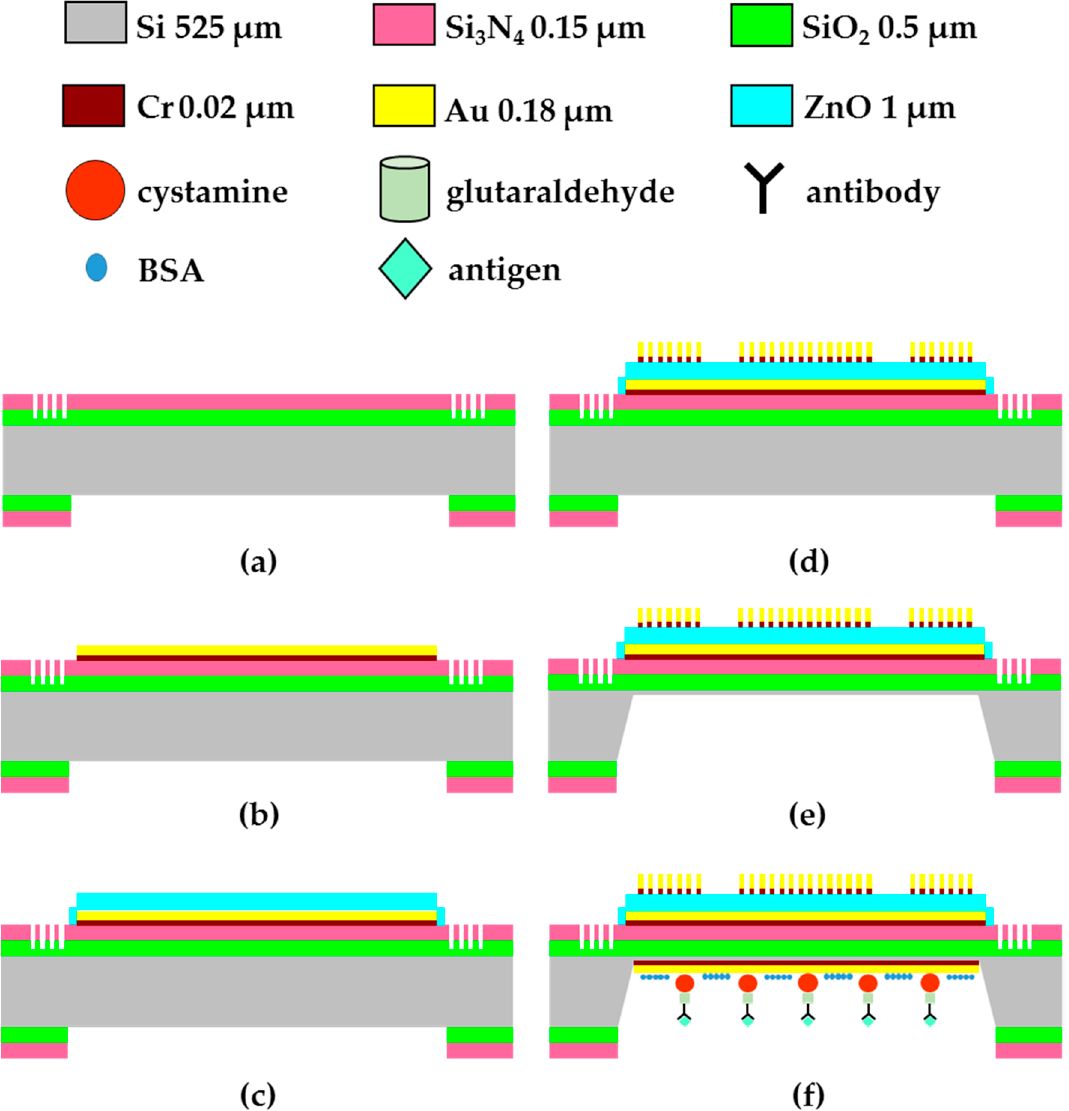
Figure 1. Main processing steps of the proposed FPW device: ( a ) deposit SiO 2 /Si 3 N 4 , etch Si-groove RGS, and pattern backside SiO 2 /Si 3 N 4 ; ( b ) deposit and pattern Cr/Au ground electrode; ( c ) deposit and pattern ZnO; ( d ) deposit and pattern Cr/Au IDTs; ( e ) etch the backside silicon by using 30 wt % KOH at 60 ◦ C and 30 wt % KOH at 27 ◦ C; ( f ) the THC antibody has to be coated on the back-side silicon cavity to catch the THC antigen in urine.